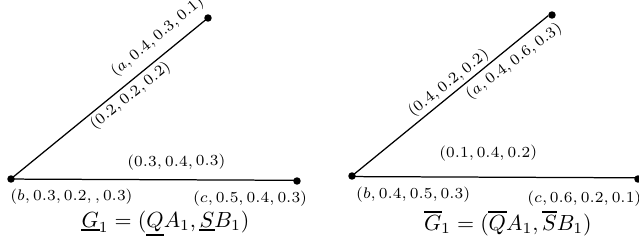
= ( G ) Figure 6. Neutrosophic soft rough graph G 1 “ p G 1 , G 1 , G 1 1 1